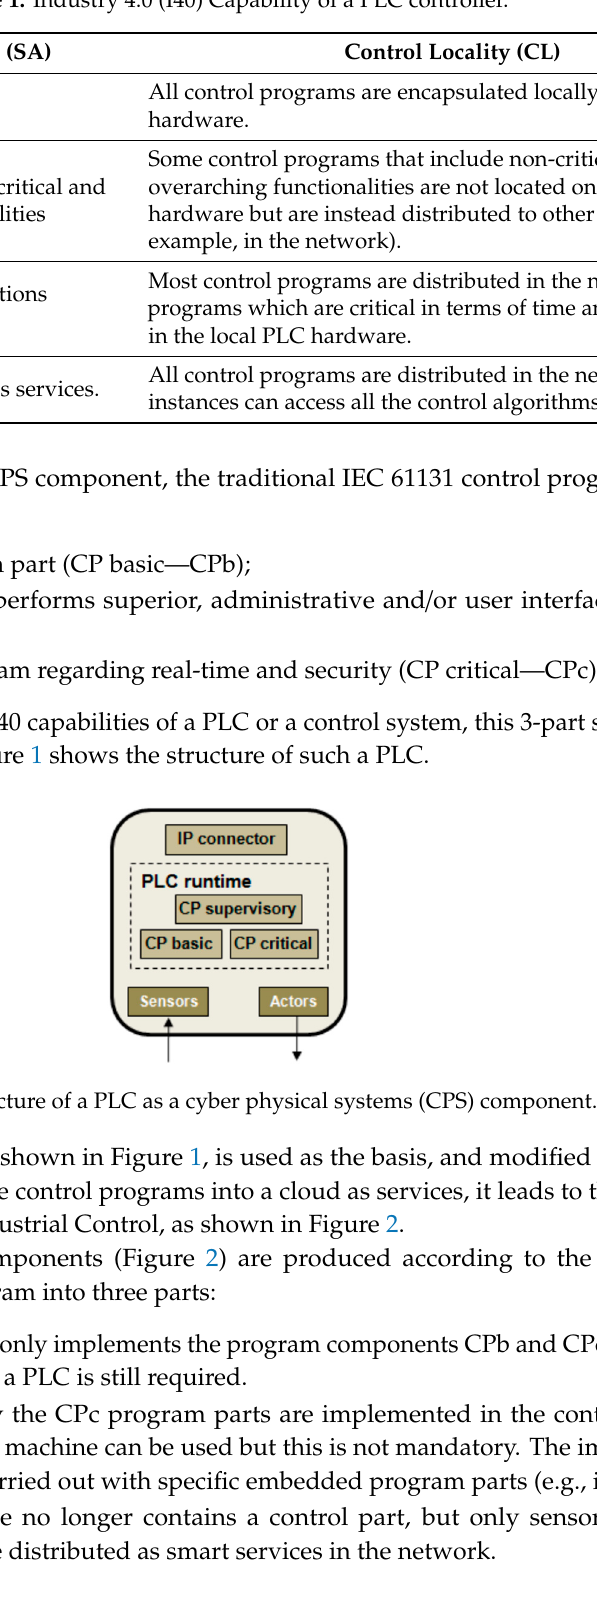
Table 1. Industry 4.0 (I40) Capability of a PLC controller.